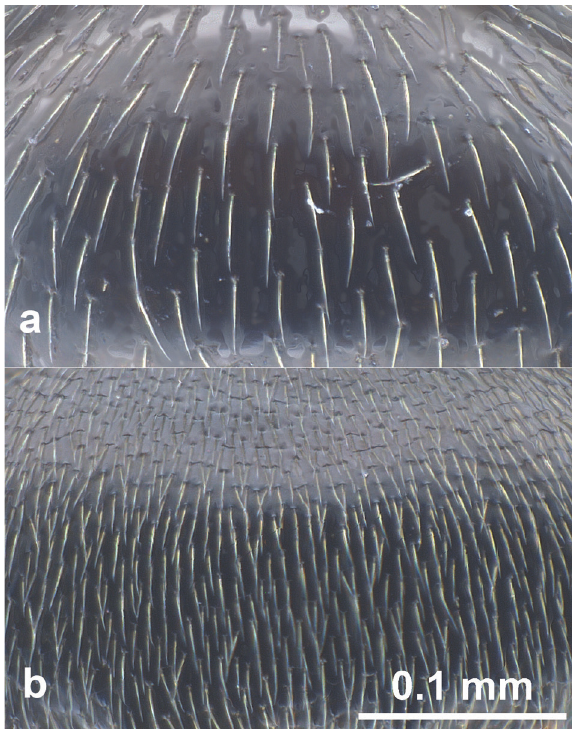
Figure 1. Surface of posterior part of 1 st gaster tergite of a work- er of Plagiolepis taurica ( a ) and Pl. schmitzii ( b